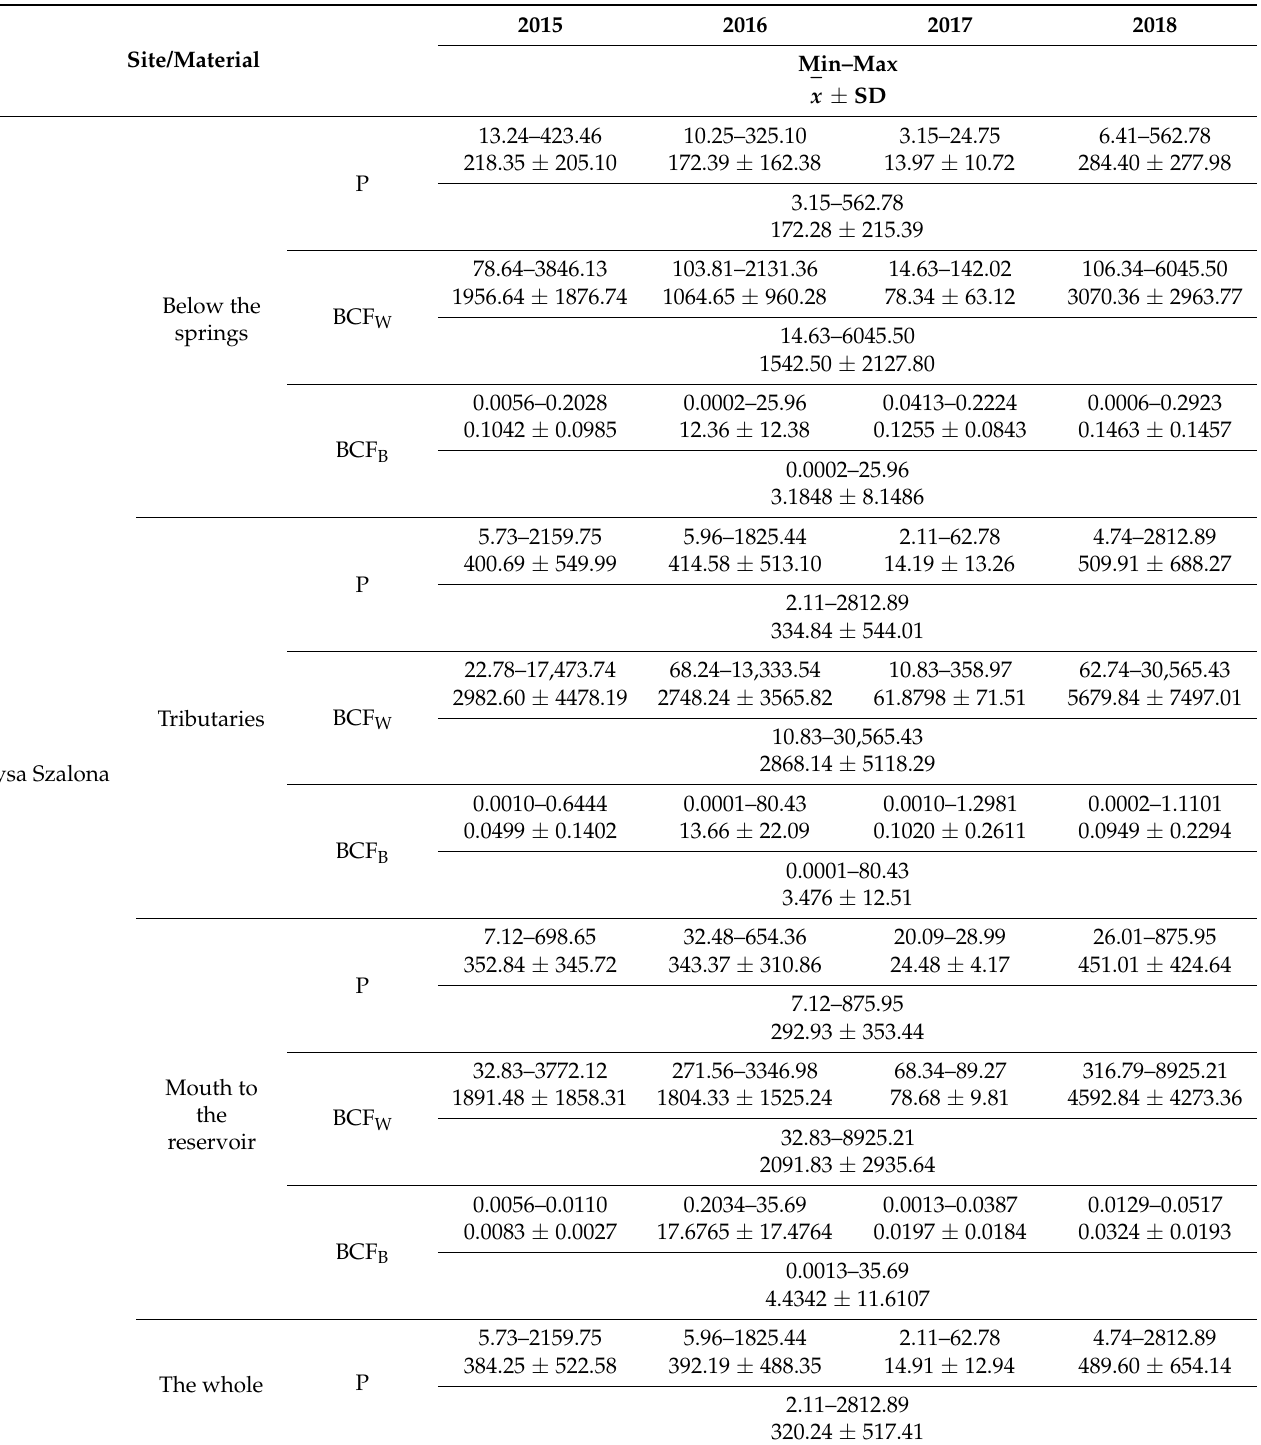
Table 2. Aluminum content (mgAl · kg − 1 on dry weight basis) in aquatic plants over a four-year study